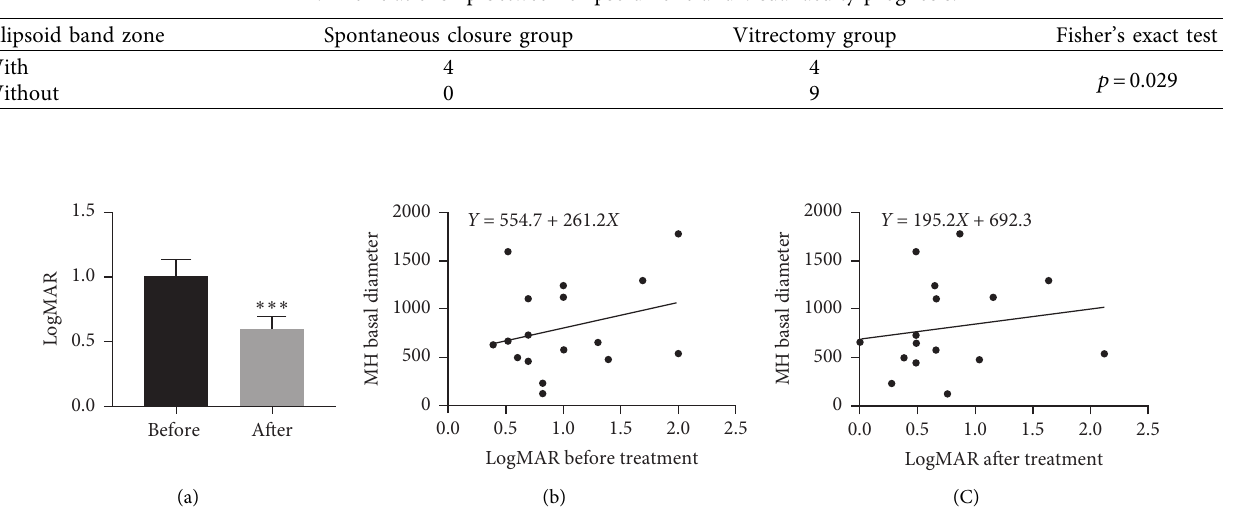
Figure 5: BCVA before and after treatment. (a) For all 17 eyes in our study, BCVA improved from median logMAR 1.01 ± 0.50 to 0.59 ± 0.40 at the final follow-up visit ( p < 0.001). Preoperative macular hole basal diameter was positively correlated with (b) preoperative ( r � 0.07, p � 0.2) and (C) postoperative ( r � 0.02, p � 0.5) logMAR visual